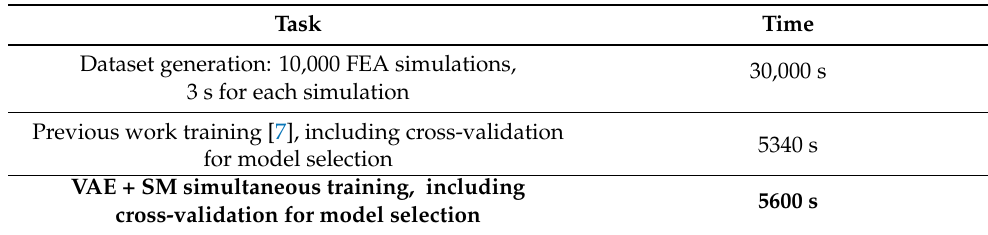
Table 6. Model training-related costs. Task Time Dataset generation: 10,000 FEA simulations, 3 s for each simulation Previous work training [7], including